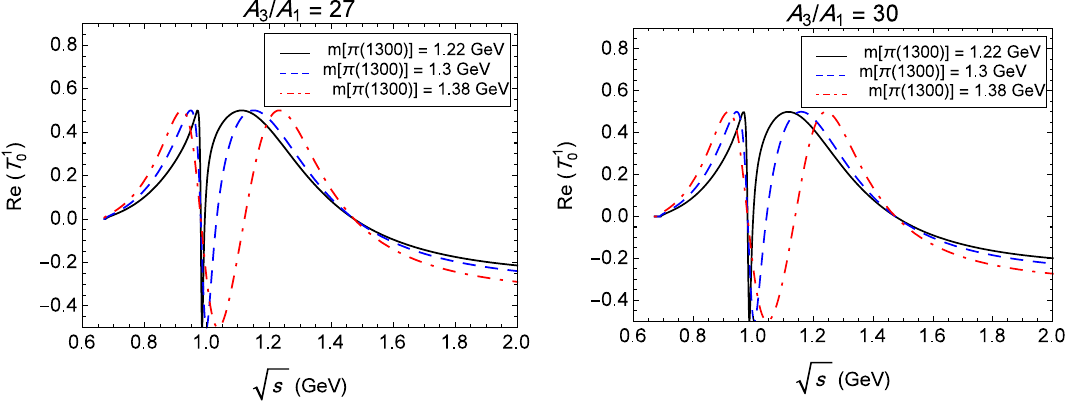
Fig. 7 Real part of the unitarized πη scattering amplitude computed in GLSM for A 3 / A 1 = 27 (left) and A 3 / A 1 = 30 (right) for three different choices of m [ π( 1300 ) ] (with scenario 3 I discussed in Sect. 4)